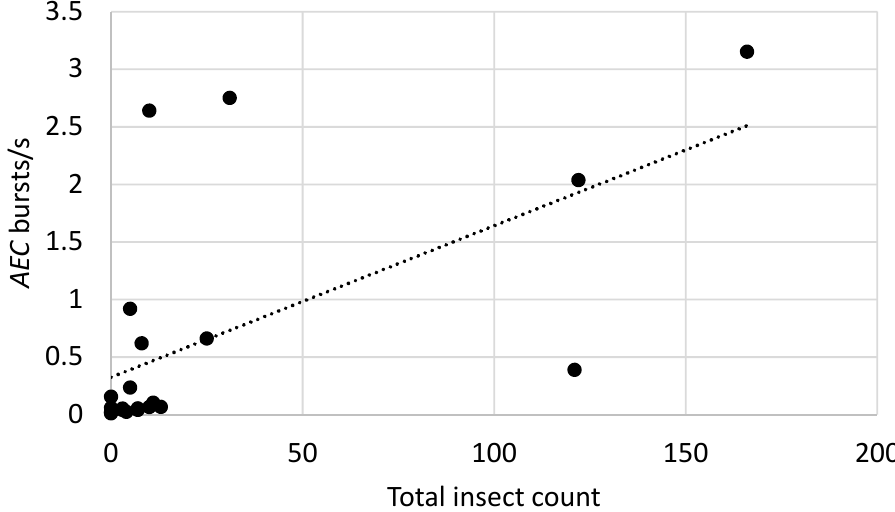
Figure 3. Relationship between insect sound burst rates and total counts of P. truncatus and S. zeamais for the AEC system in recordings from 21 bags at Kiganjo, Nairobi, Nakuru, and Sagana warehouses. Filled circles indicate burst rates from individual bags with specified total counts of the two species. Dotted line indicates the linear regression of insect sound bursts/s on the total counts.